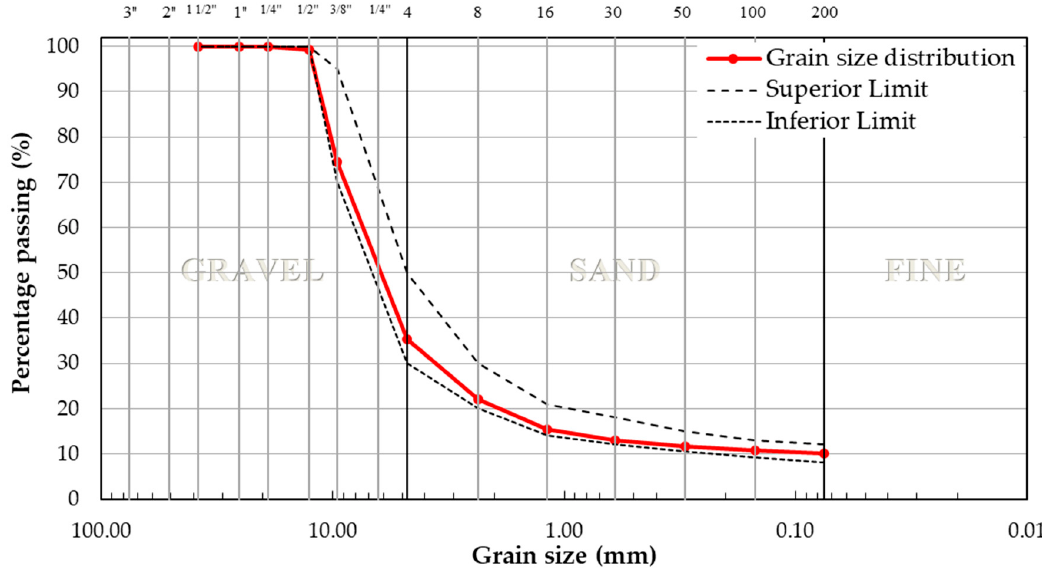
Figure 2. Grain size distribution of aggregates using the AASHTO MP-8 procedure.